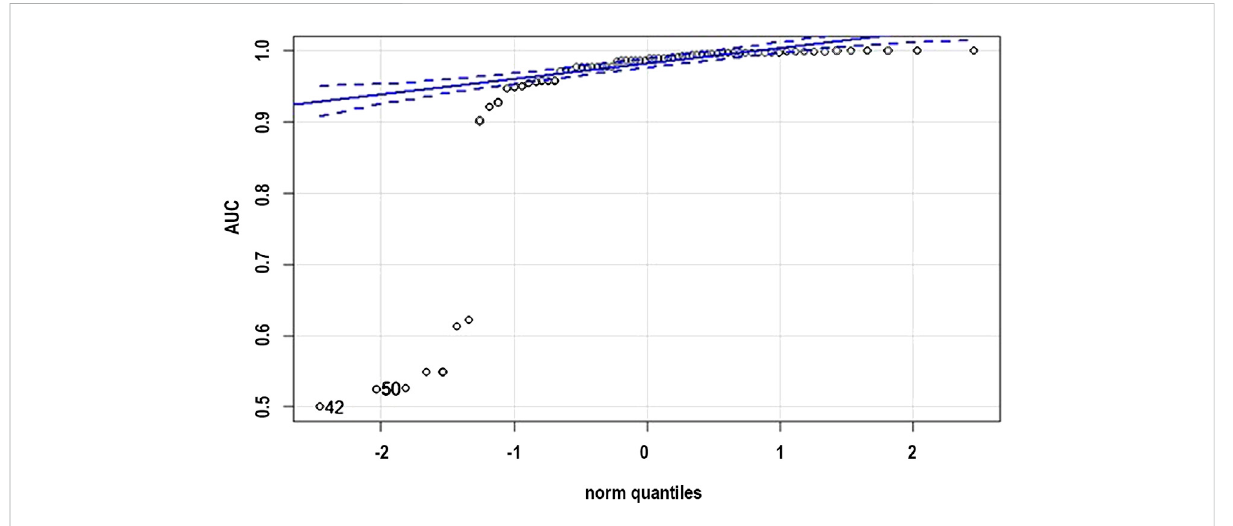
FIGURE 5 QQ plot normality check for the